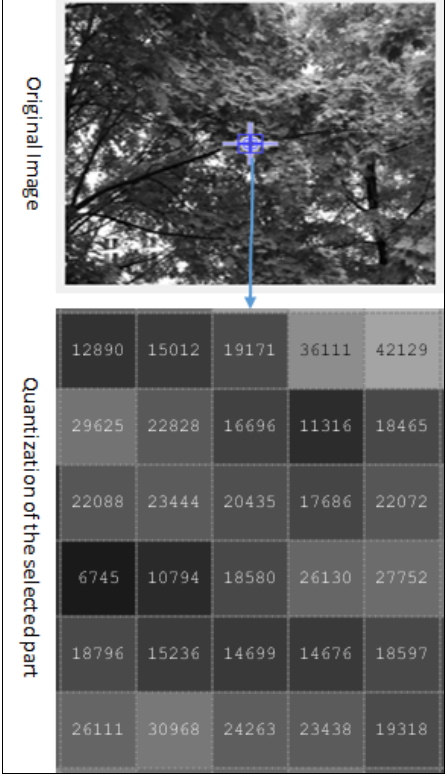
Figure 3. A 16-bit greyscale